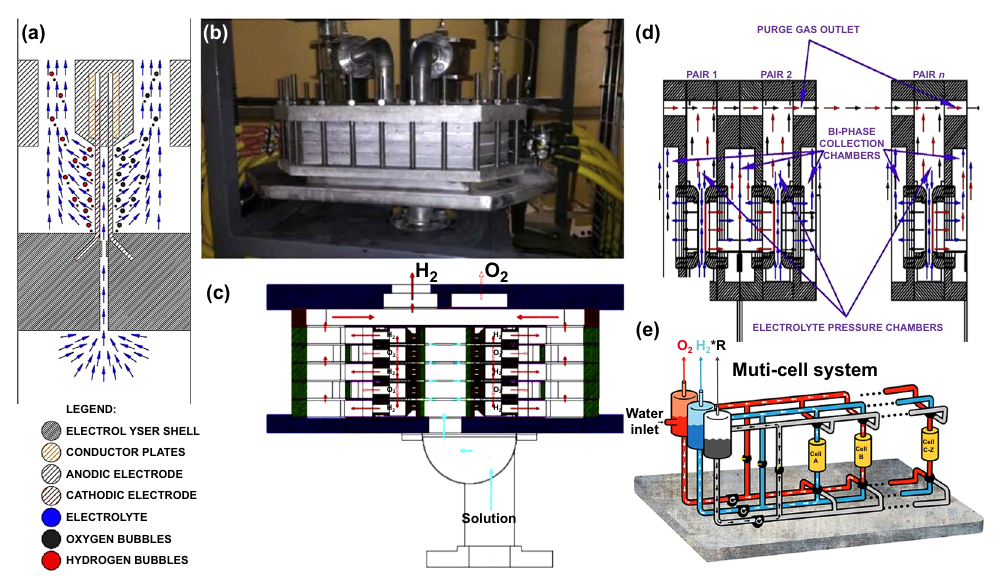
Fig. 5 a Schematic diagram of filtration mesh electrode encapsulated in a single injection assembly, b a photograph of the horizontal filter press DEFT electrolyzer stack, and c a diagram of a cross section of the electrolyzer stack assembly. Reproduced with permission from Ref.